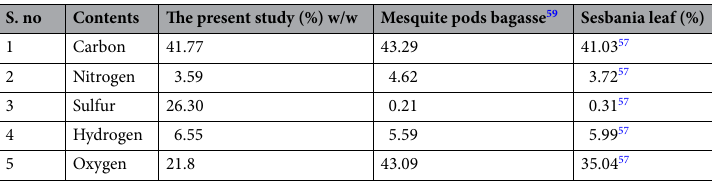
Table 2. Ultimate analysis of Pj pods on a dry basis.